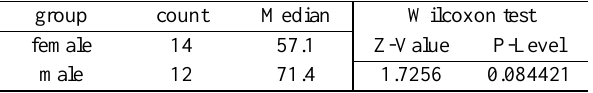
Table 4 Gender distribution of students and results of the